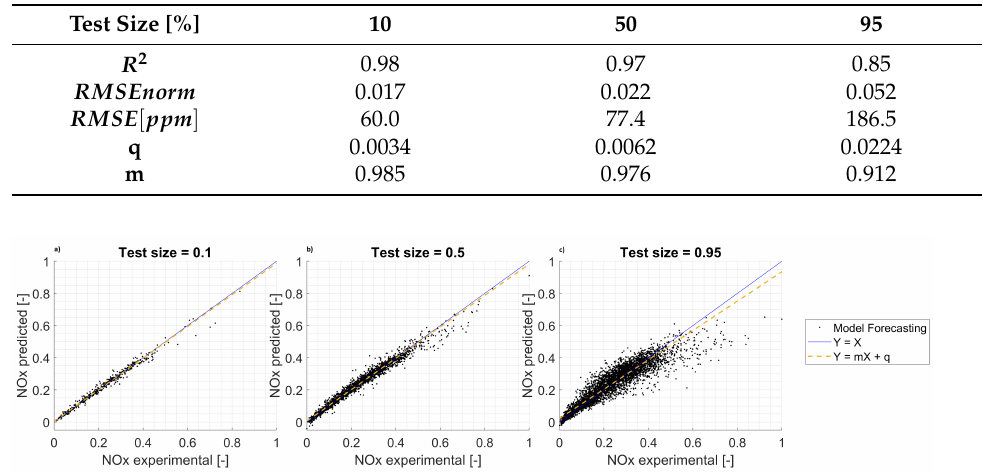
Table 4. Summary of performance prediction results for test case Bench – Bench . The test size is here reported for the sensitivity analysis, considering the different percentage values 10%, 50% and 95%.